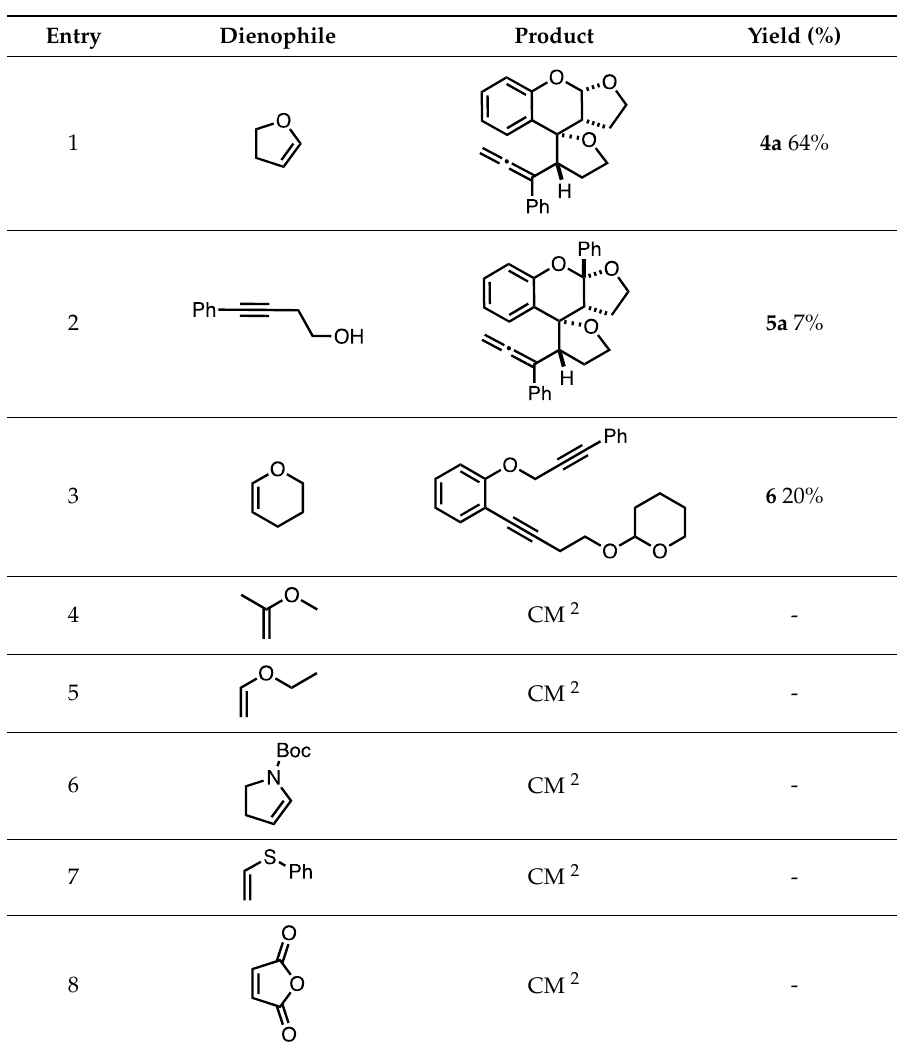
Table 1. Optimization of the reaction conditions. 1